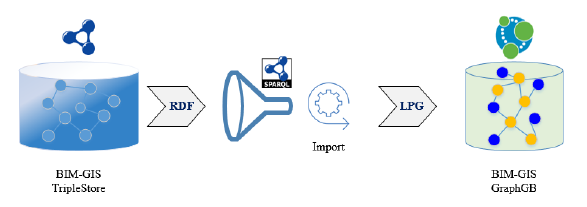
Figure 2. Transformation pipeline